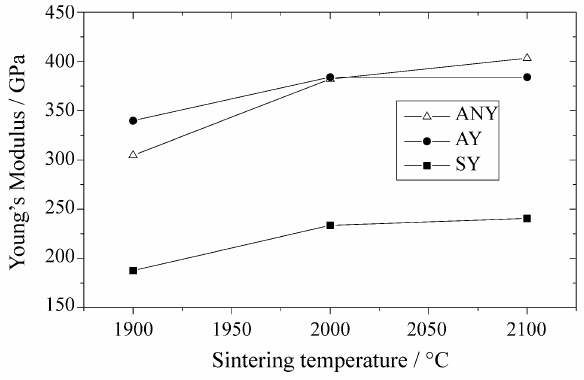
Figure 6. Youngs modulus of the sintered samples vs. sintering tempera- ture.